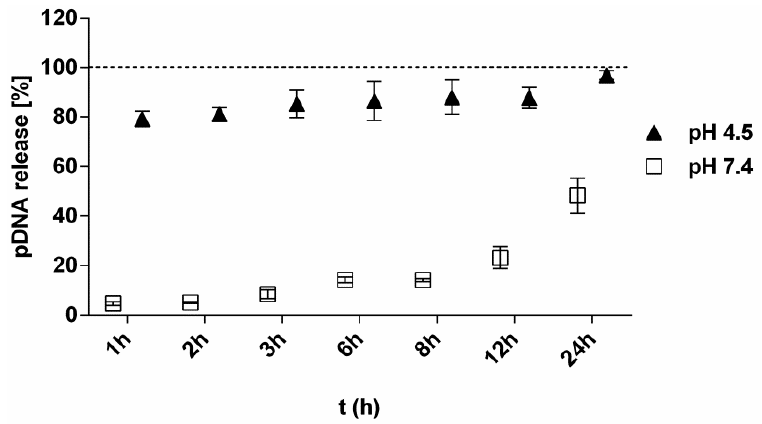
Figure 1. Release profiles of pDNA (10 µg) from pDNA/TMC-NPs-0.7 at pH 4.5 ( ▲ ) and pH 7.4 (□) at 37 °C for 24 h, calculated as a percent in relation to 100% pDNA in solution (dotted line). All measurement points are expressed as the means for a minimum of three measurements ± SEM.